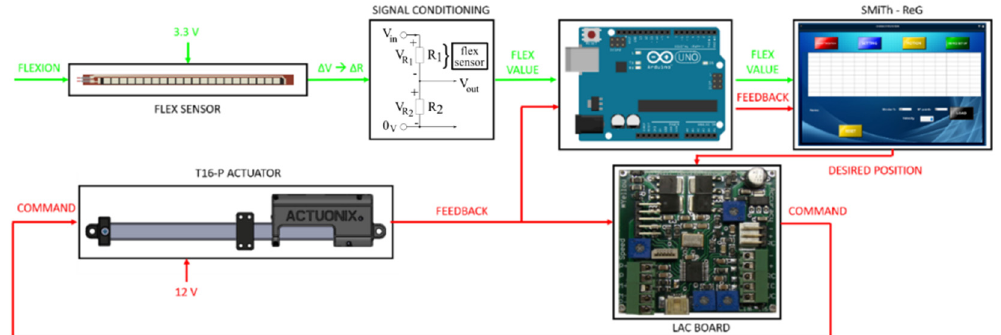
Figure 9. Block diagram of the test bench hardware structure.